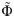
Workflow process of the CoDiNA R package.Input data for the CoDiNA R package can be any networks, filtered for containing only significant links (according to the network construction method used). Edge list is a list containing all the links and their weights. The user can assign a weight of zero to links for which the p-value is not significant. The function MakeDiffNet() classifies the links into the Φ and Φ˜ categories, calculates and normalises the scores. Its output is used as input for assigning the nodes into categories by the function ClusterNodes(). The plot() function can be used on the output from MakeDiffNet() and automatically calls the function ClusterNodes().